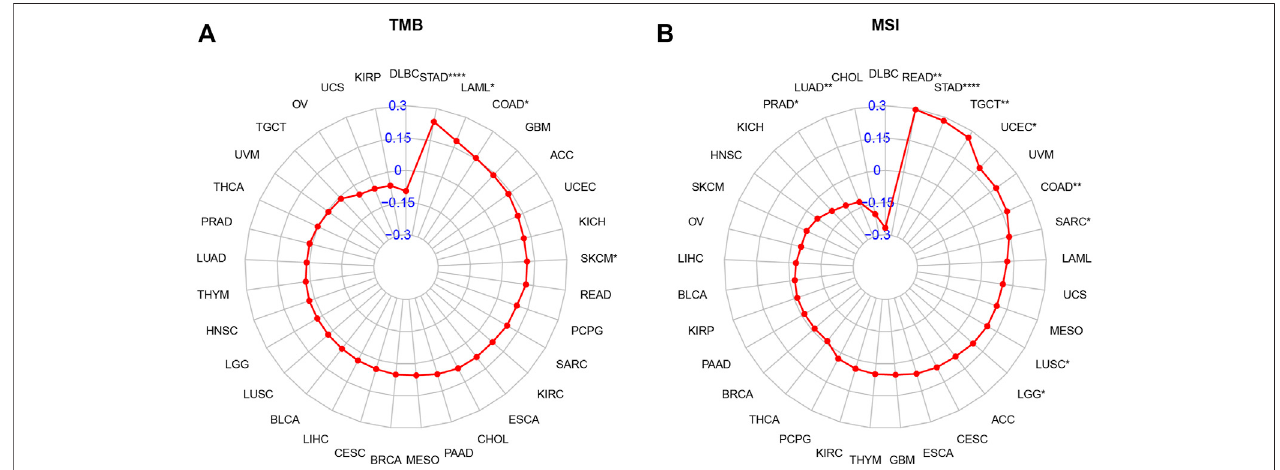
FIGURE 11 | Relationship of AP3S1 expression and tumor mutational burden (TMB), microsatellite instability (MSI). (A) Radar map illustrating the relationship between AP3S1 expression and TMB. (B) Radar map illustrating the relationship between AP3S1 expression and MSI. The red lines represent correlation coef fi cients, and blue values represent ranges. Spearman correlation test, * p < 0.05, ** p < 0.01, *** p <